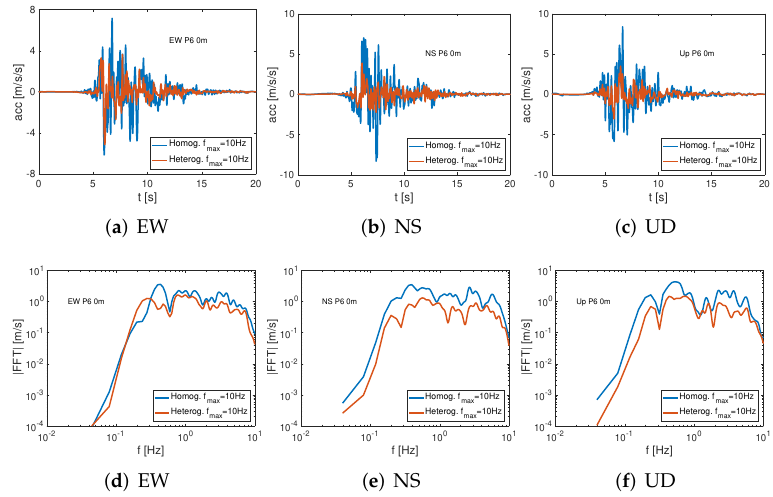
Figure 15. Synthetic acceleration time-histories ( a – c ) and Fourier’s spectra ( d – f ) filtered at 0–10 Hz at P6 (0 m G.L.) obtained in O2 simulation. Comparison between homogeneous (blue) and heteroge- neous (red) models.